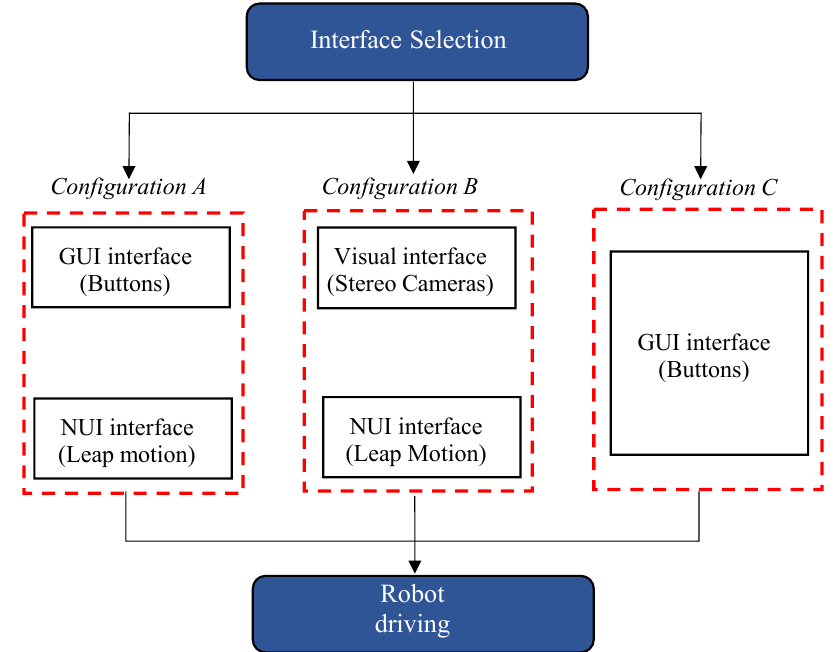
Figure 8. Evaluation interface